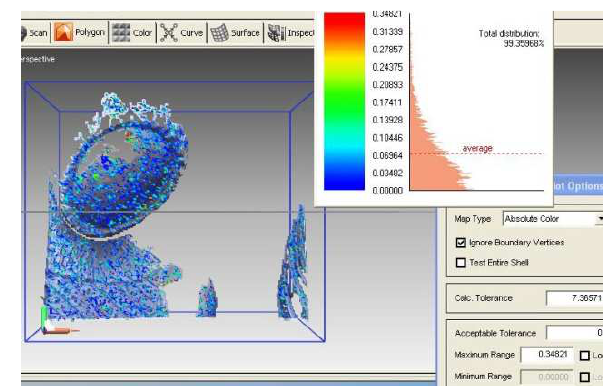
Figure 11. The deviations points-model (from the VIVID 300 scans) for the head of St. George